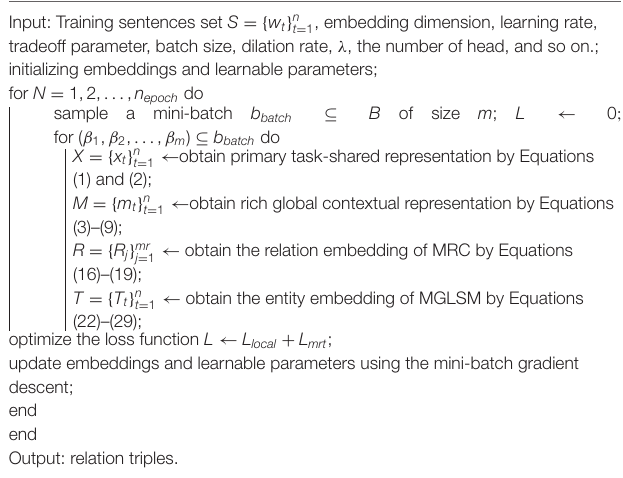
Algorithm 1 : | Training algorithm for